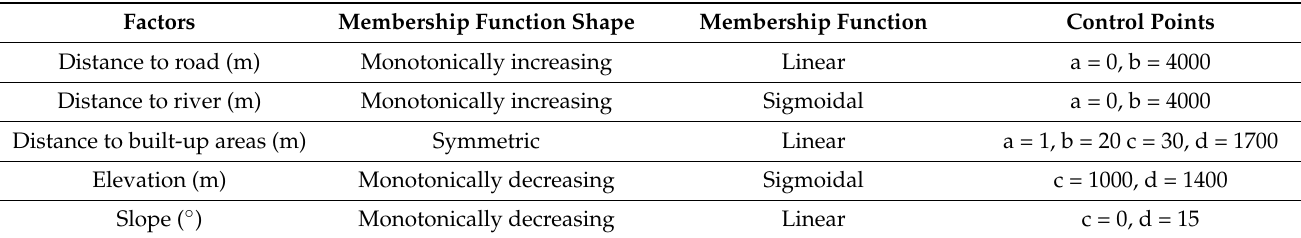
Table 2. Factors, constraints, membership functions and control points used for the preparation of suitability maps (modified from Gidey et al. [61] and Hyandye and Martz